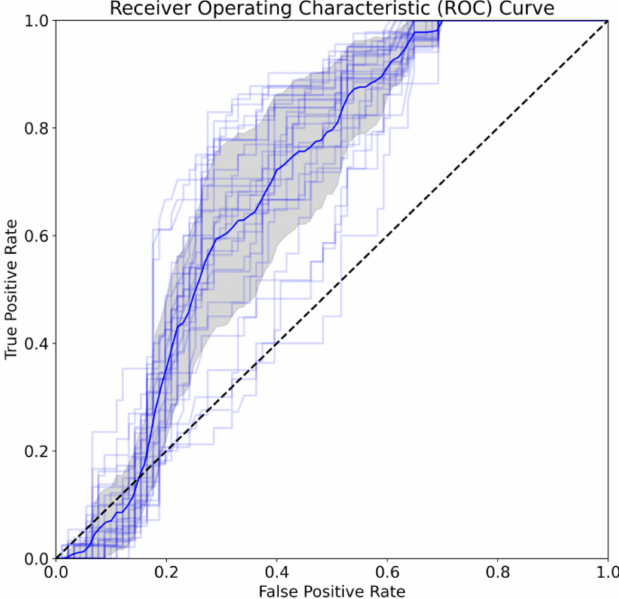
Figure 5. ROC curve for predictions of the tracks displaying the performance at various classification thresholds. All folds are included in light blue with the average indicated in the dark blue and the standard deviation in the grey